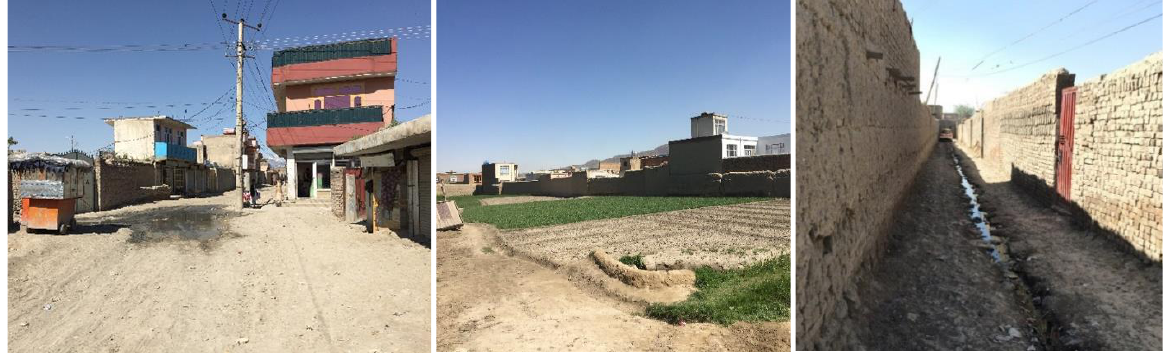
Figure 2. Pictures of the area showing the transformation of agriculture land